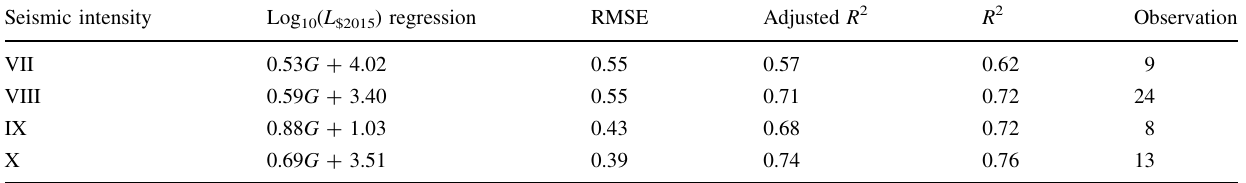
Table 3 Regression of the economic losses adjusted to 2015 USD value ( L $2015 ) considering GDP.Unit as the exposure-related variable for seismic intensities between VII and X (Eq. 3) Seismic